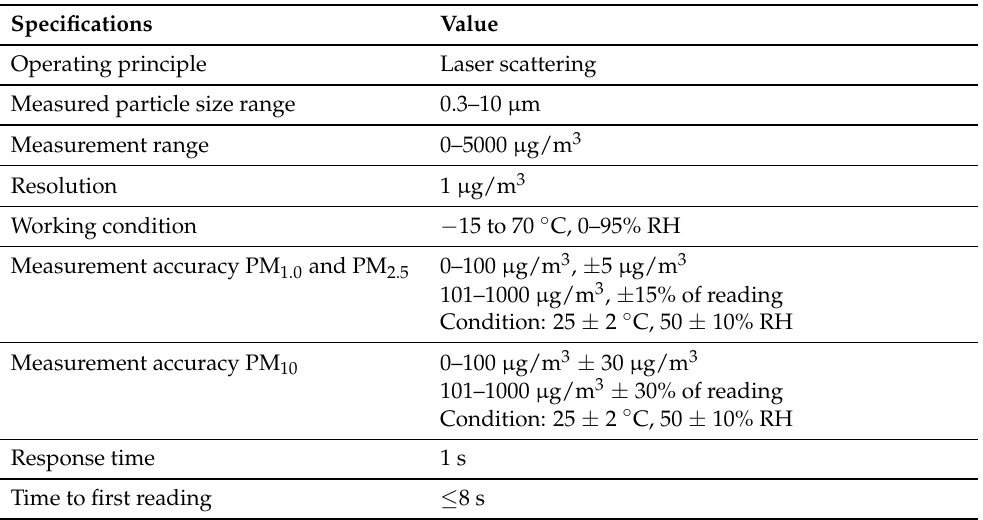
Table 2. Specifications of the Cubic PM3015SN particulate matter sensor [24] 1 .